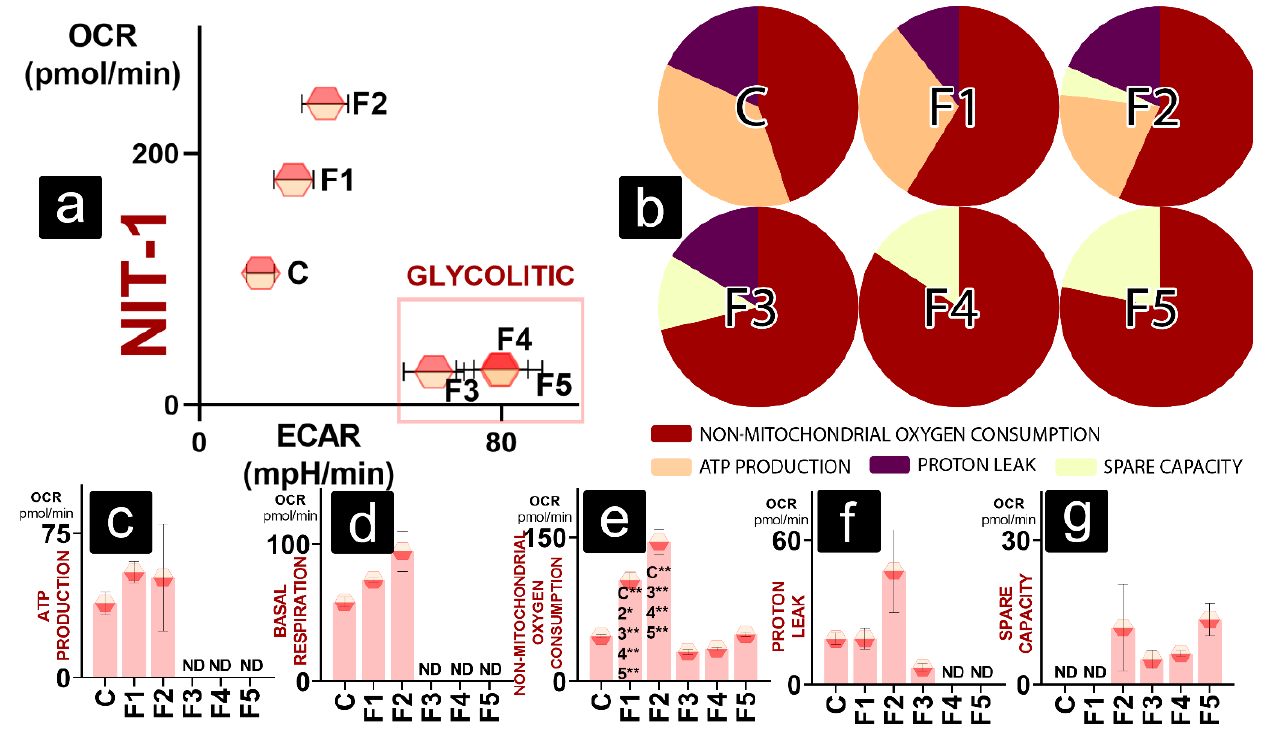
Figure 6. Bioenergetics of NIT-1 cells showing ( a ) metabolic profile in normal conditions; ( b ) maximal OCR established as 100% and the oxygen consumption allotted between non-mitochondrial OCR, ATP-linked OCR, proton-leak-linked OCR, and spare-capacity-linked OCR; OCR values for ( c ) ATP production, ( d ) basal respiration, ( e ) non-mitochondrial oxygen consumption, ( f ) proton leak, and ( g ) spare capacity. p < 0.01 (*) or p < 0.05 (**). All three cell lines follow a similar bioenergetic pattern in the presence of DCA, ATP-production-linked OCR was detected only for DCA-free cells (C, F1, and F2), with no statistical difference between groups (Figure 6c). A similar trend is observed with basal shifting to anaerobic metabolism, with decreased ATP-linked OCR and increased respiration (Figure 5d). NM OCR (Figure 5e) was the highest for cells in the presence of percentage of spare-capacity-linked OCR and non-mitochondrial OCR. DCA-free gels (F1 and F2), which was significantly higher than in control and cells exposed to DCA gels (F3, F4, and F5). This illustrates that most of the increase in total OCR for F1 and F2 (Figure 6a) comes from increased NM OCR rather than mitochondrial